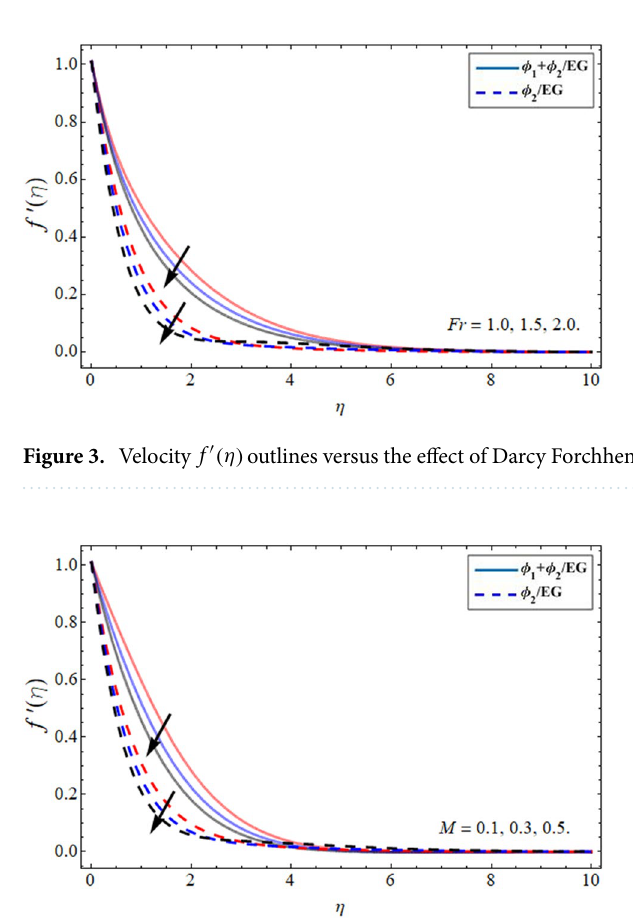
Figure 4. Velocity f ′ (η) outlines versus the effect of magnetic term M